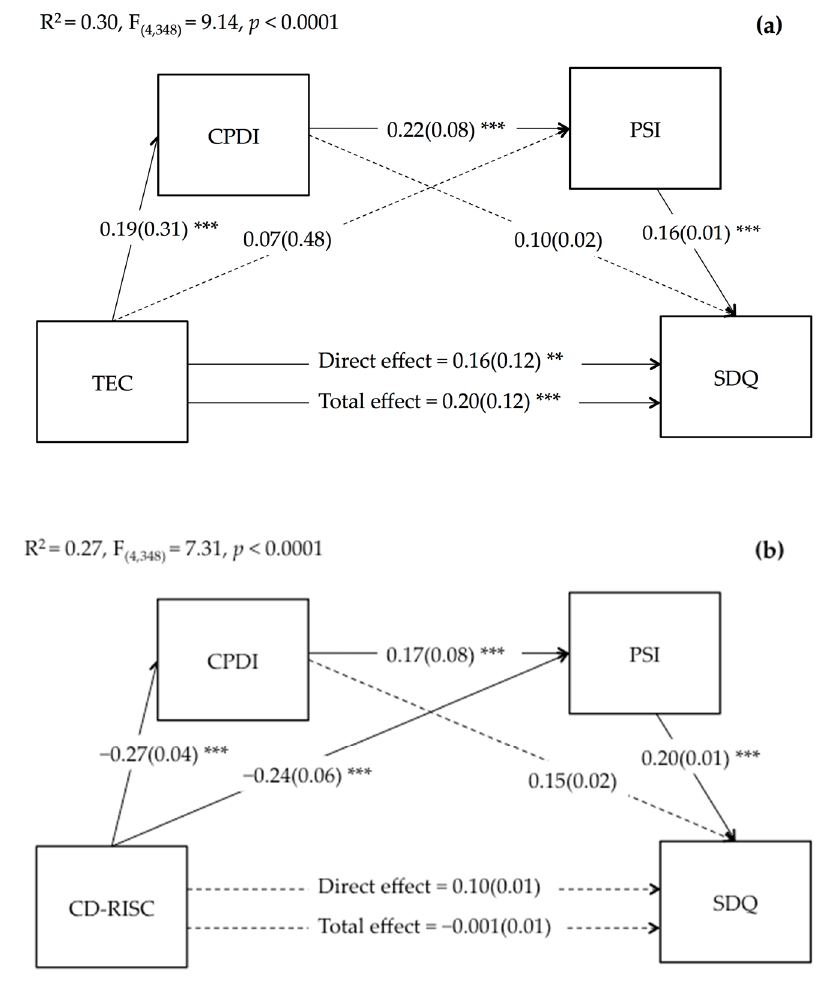
Figure 1. Serial mediation of parent’s COVID-19 peritraumatic distress (CPDI) and parenting stress (PSI) on the relationship between parent’s traumatic experiences (TEC) ( a ) and parent’s resilience (CD-RISC) ( b ) with children’s difficulties (SDQ). Coefficients shown are standardized path coefficients. Dotted lines represent non-significant parameters. ** p < 0.01, *** p < 0.001.